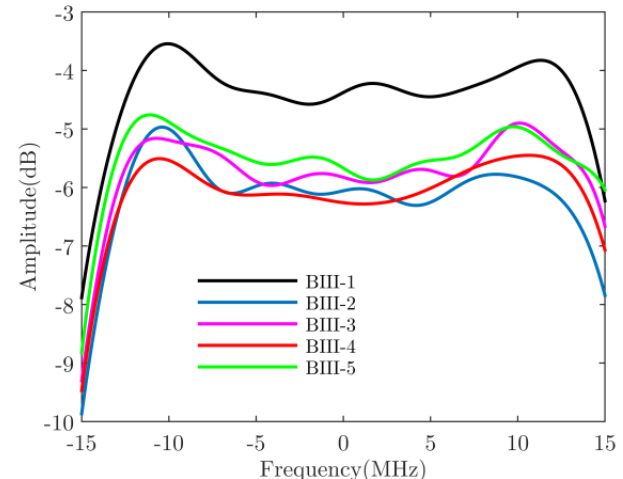
Figure 9. BIII-2 amplitude characteristic.